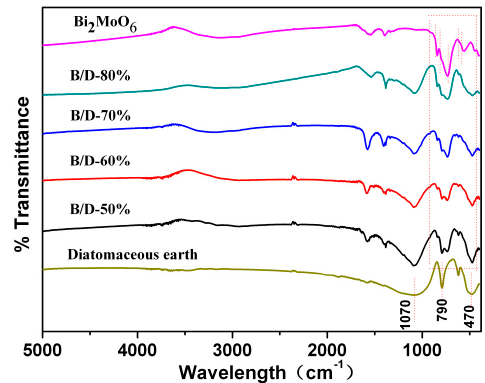
Figure 2. FTIR spectra of Bi 2 MoO 6 , B/D-50%, B/D-60%, B/D-70%, B/D-80%, and diatomite.